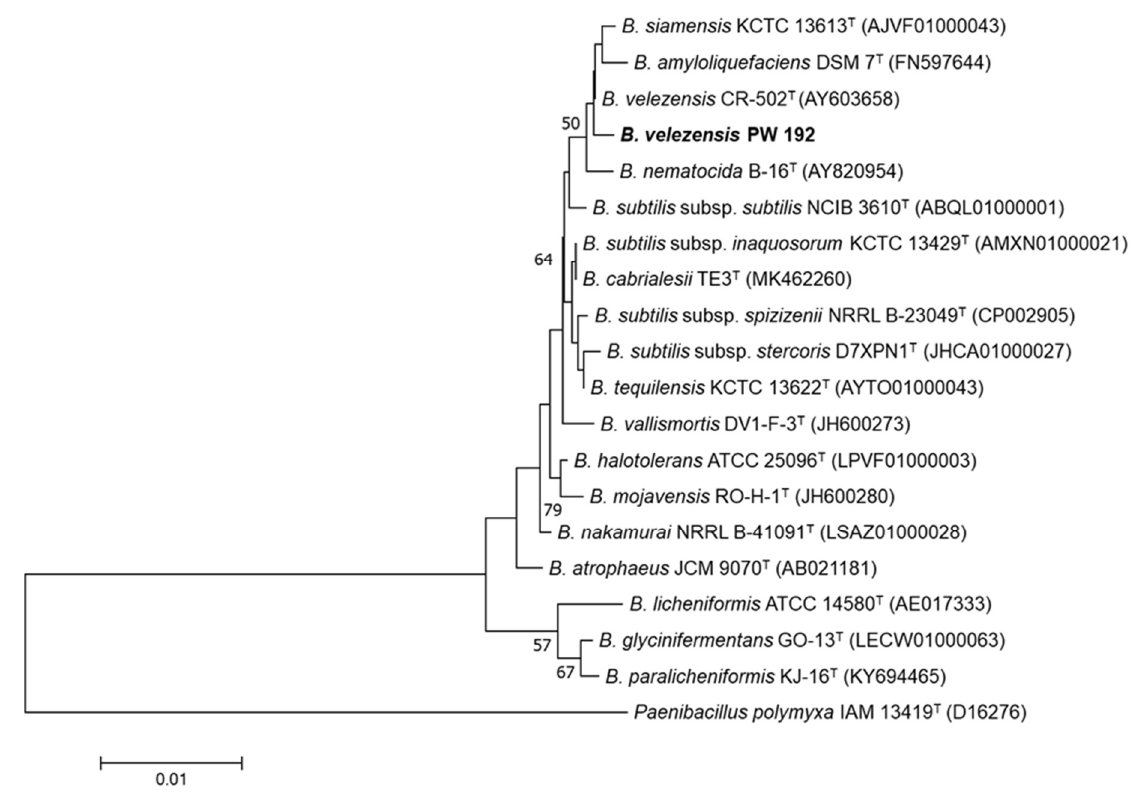
Figure 1. Neighbor-joining phylogenetic tree of B. velezensis PW192; the closely-related Bacillus spp. Paenibacillus polymyxa IAM 13419 T (D16276) was used as the outgroup. Bootstrap values above 50% or higher are shown at branch points based on 1000 resamplings. The scale bar represents 0.01 substitutions per nucleotide position.